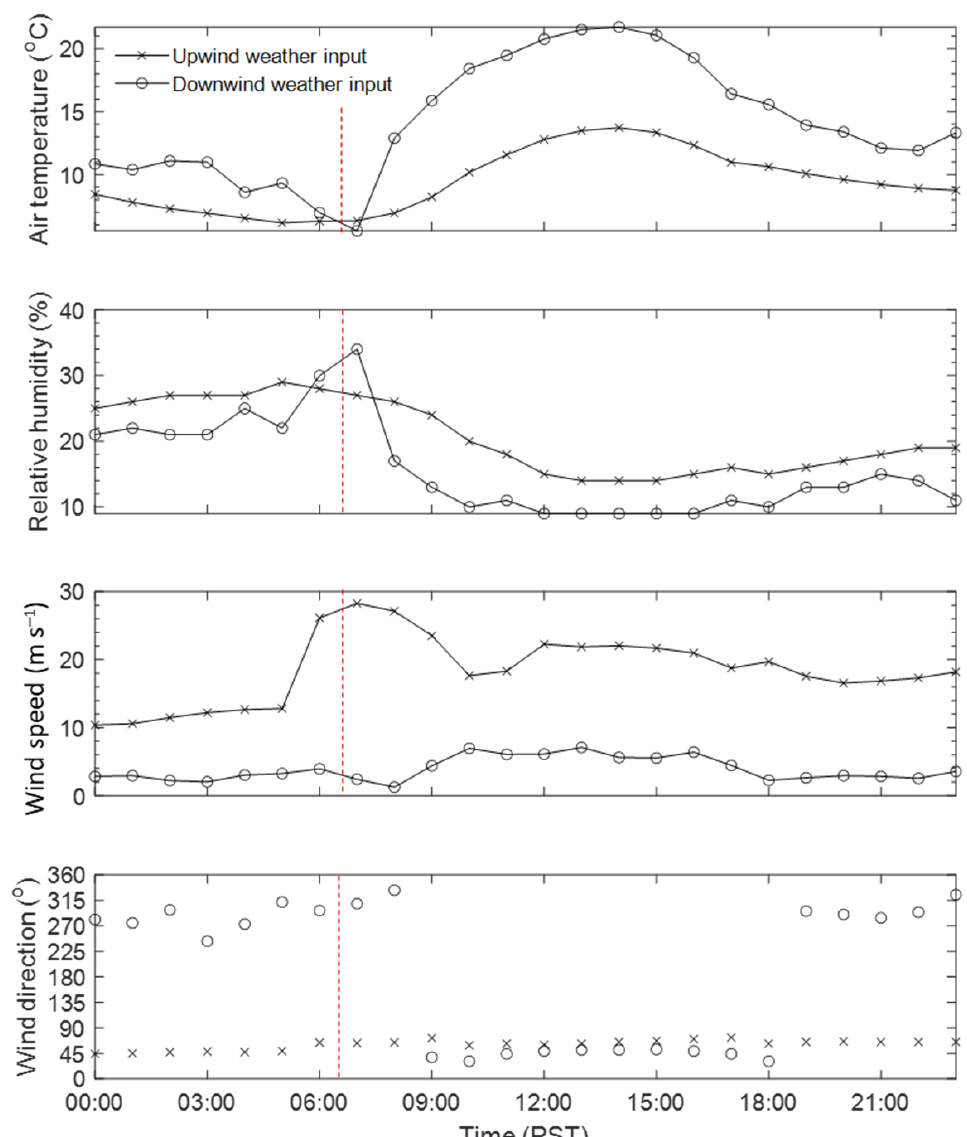
Figure 2. Input weather stream used in the Prometheus fire growth model simulations. The dashed red vertical line indicates approximate fire ignition time (06:25 PST). The locations of the upwind and downwind weather stream inputs are shown in Figure 1.